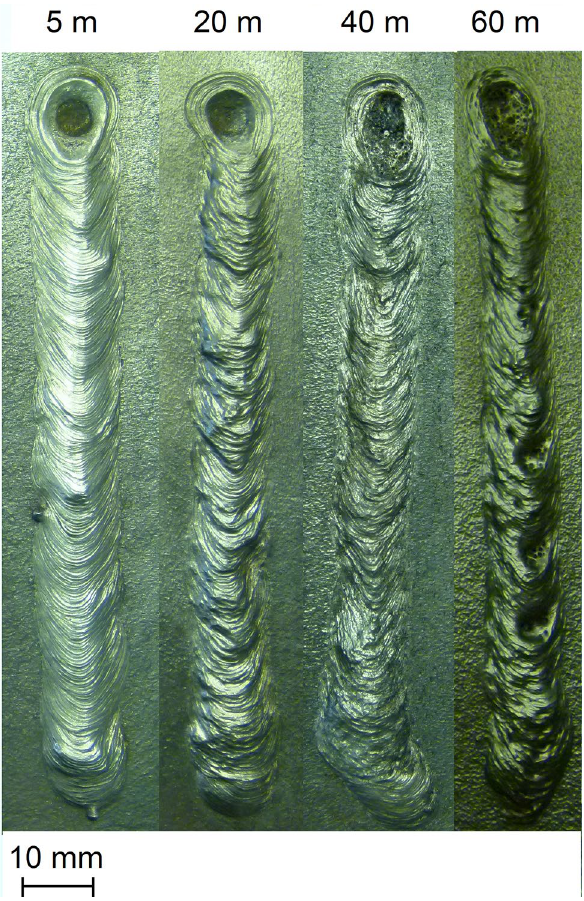
Fig. 12 Bead on plate weld seams welded with the stick electrode HK9 in the water depth 5 m, 20 m, 40 m, and 60 m. The parameters used are listed in Table